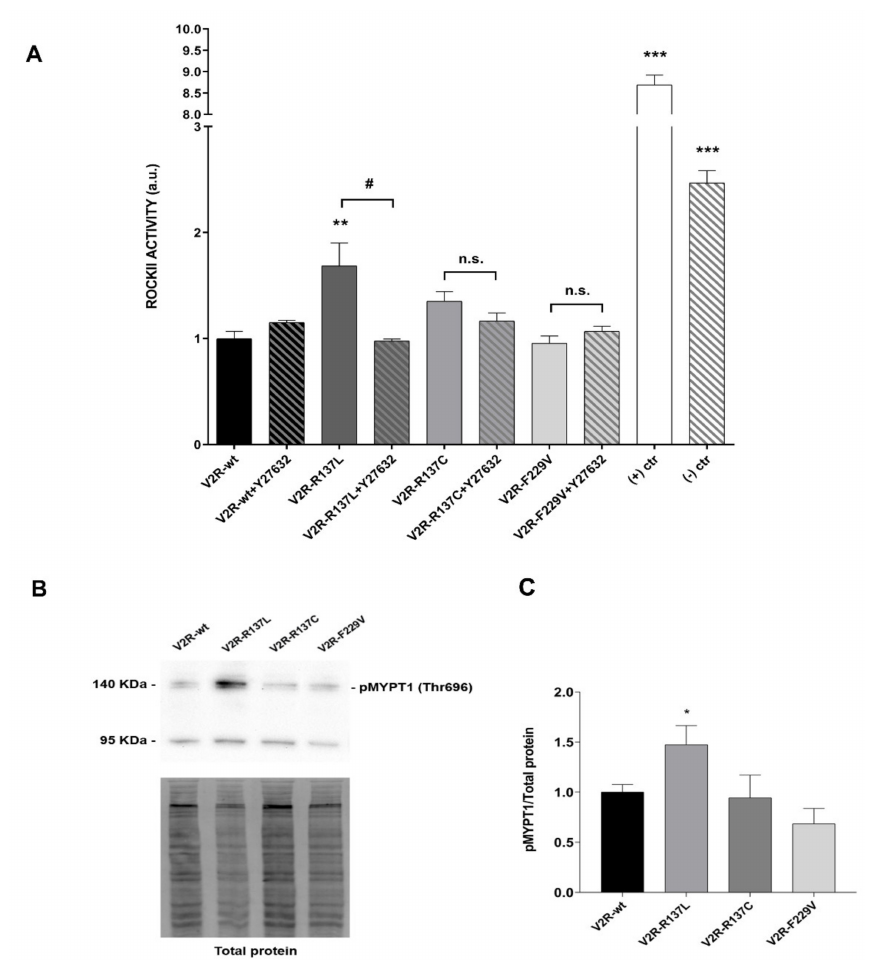
Figure 4. ROCK activity in MCD4 cells expressing wild type and mutated V2R. ( A ). ROCK activity in cells expressing the wild-type V2R or the constitutively active R137L, R137C and F229V under basal conditions in the presence or the absence of the ROCK inhibitor Y27632 (1 mM), was tested using a ROCK activity assay Kit as described in “Materials and methods”. V2R-R137L mutant displayed a significantly higher ROCK activity sensitive to Y27632. The data are normalized compared to the activity measured in V2R-wt MCD4 expressing cells and are represented as the means ( ± S.E.M.) of 3 independent experiments. (** p < 0.01 or *** p < 0.001 vs. V2R-wt; # p < 0.05 vs. V2R-R137L; n.s.: not significant vs. V2R-R137C or V2R-F229V). The histogram includes the activity of ROCK enzyme at 1 mU / µ L, in the absence (positive control ( + ) ctr), or in the presence (negative control (-) ctr), of the ROCK inhibitor, Y27632 (1 mM). ( B ) . Representative western blot showing ROCK activity by monitoring phosphorylation of MYPT1 on Thr-696 (pT696-MYPT1), a downstream protein substrate of ROCK, in cells expressing the wild-type V2R or the constitutively active R137L, R137C and F229V under basal conditions. The intensity of MYPT1 bands was normalized to total protein (see “Materials and methods” for stain-free technique). ( C ) . Densitometric analysis of pT696-MYPT1 bands normalized to total protein. The data, normalized to wild-typeV2R, are expressed as means ( ± S.E.M.) of 5 experiments (* p < 0.05 vs.